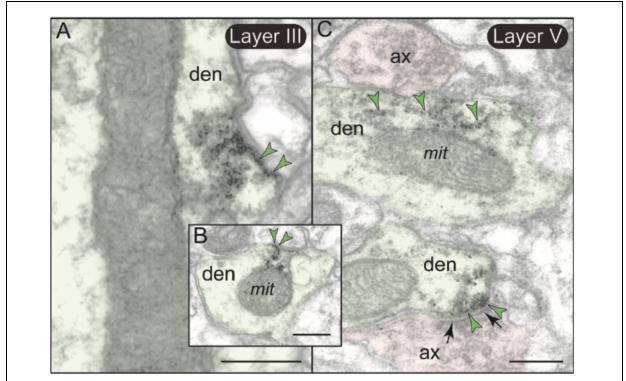
FIGURE 11 | Post-synaptic expression of mGlu3 in dendritic shafts in layers II/III and V of rat PL mPFC. (A,B) In both layers II/III and V (but shown here in layer II/III), mGlu3s are visualized on the plasma membranes of dendritic shafts, often on the patch of membrane facing a mitochondrion. It is possible that mGlu3s are regulating cAMP influences on mitochondria at this location, e.g., regulating cAMP drive on internal calcium release near these